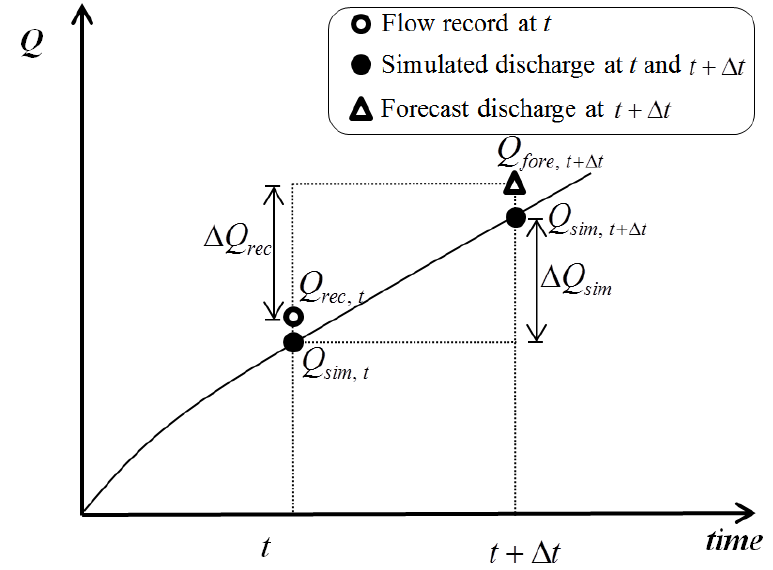
Figure 1. Schematic of the updating